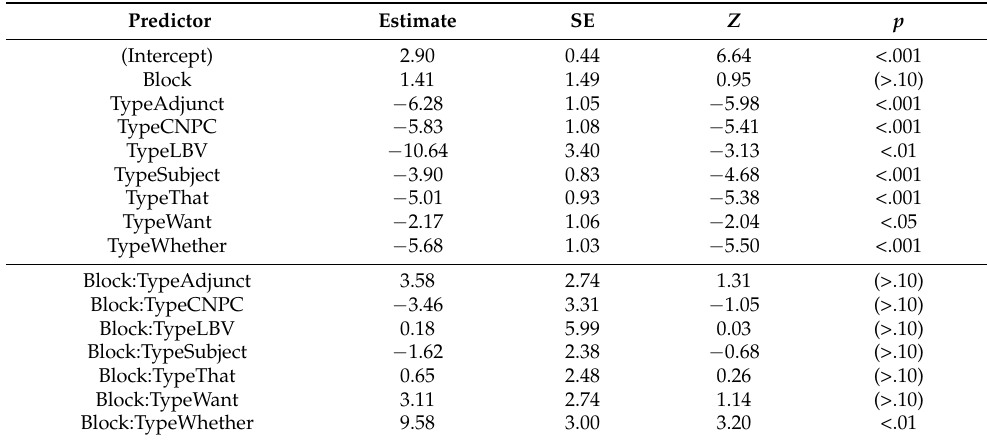
Table 1. Table of fixed effects for Experiment I.